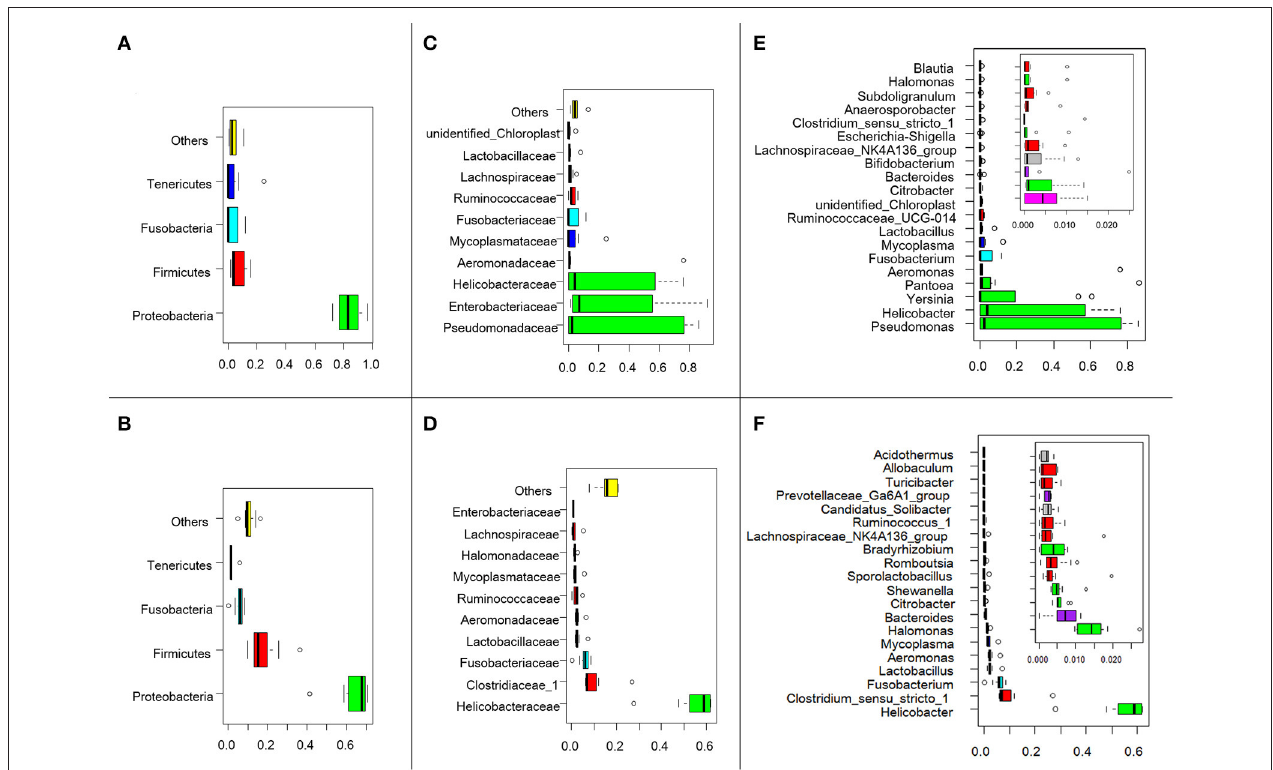
FIGURE 1 | Swan fecal microbiota abundances and phylogenetic profiles at the phylum, family and genus levels for H5N1 virus infected individuals and healthy controls. A phylum abundance variation box plot for the top 4 phylum in the H5N1-positive samples (A) or healthy controls (B) is shown. The central rectangles represent the interquartile range (IQR), which spans the first quartile to the third quartile. The line inside the rectangle shows the median and “whiskers” above and below the box show the locations of the minimum and maximum within 1.5 IQR from the first and third quartiles. The circles represent outliers beyond the whiskers. The 10 most abundance family in the H5N1-positive samples (C) or healthy controls (D) is shown. And the 20 most abundance genera in the H5N1-positive samples (E) or healthy controls (F) is shown. The color of each family and genera corresponds with the color of its respective phylum.